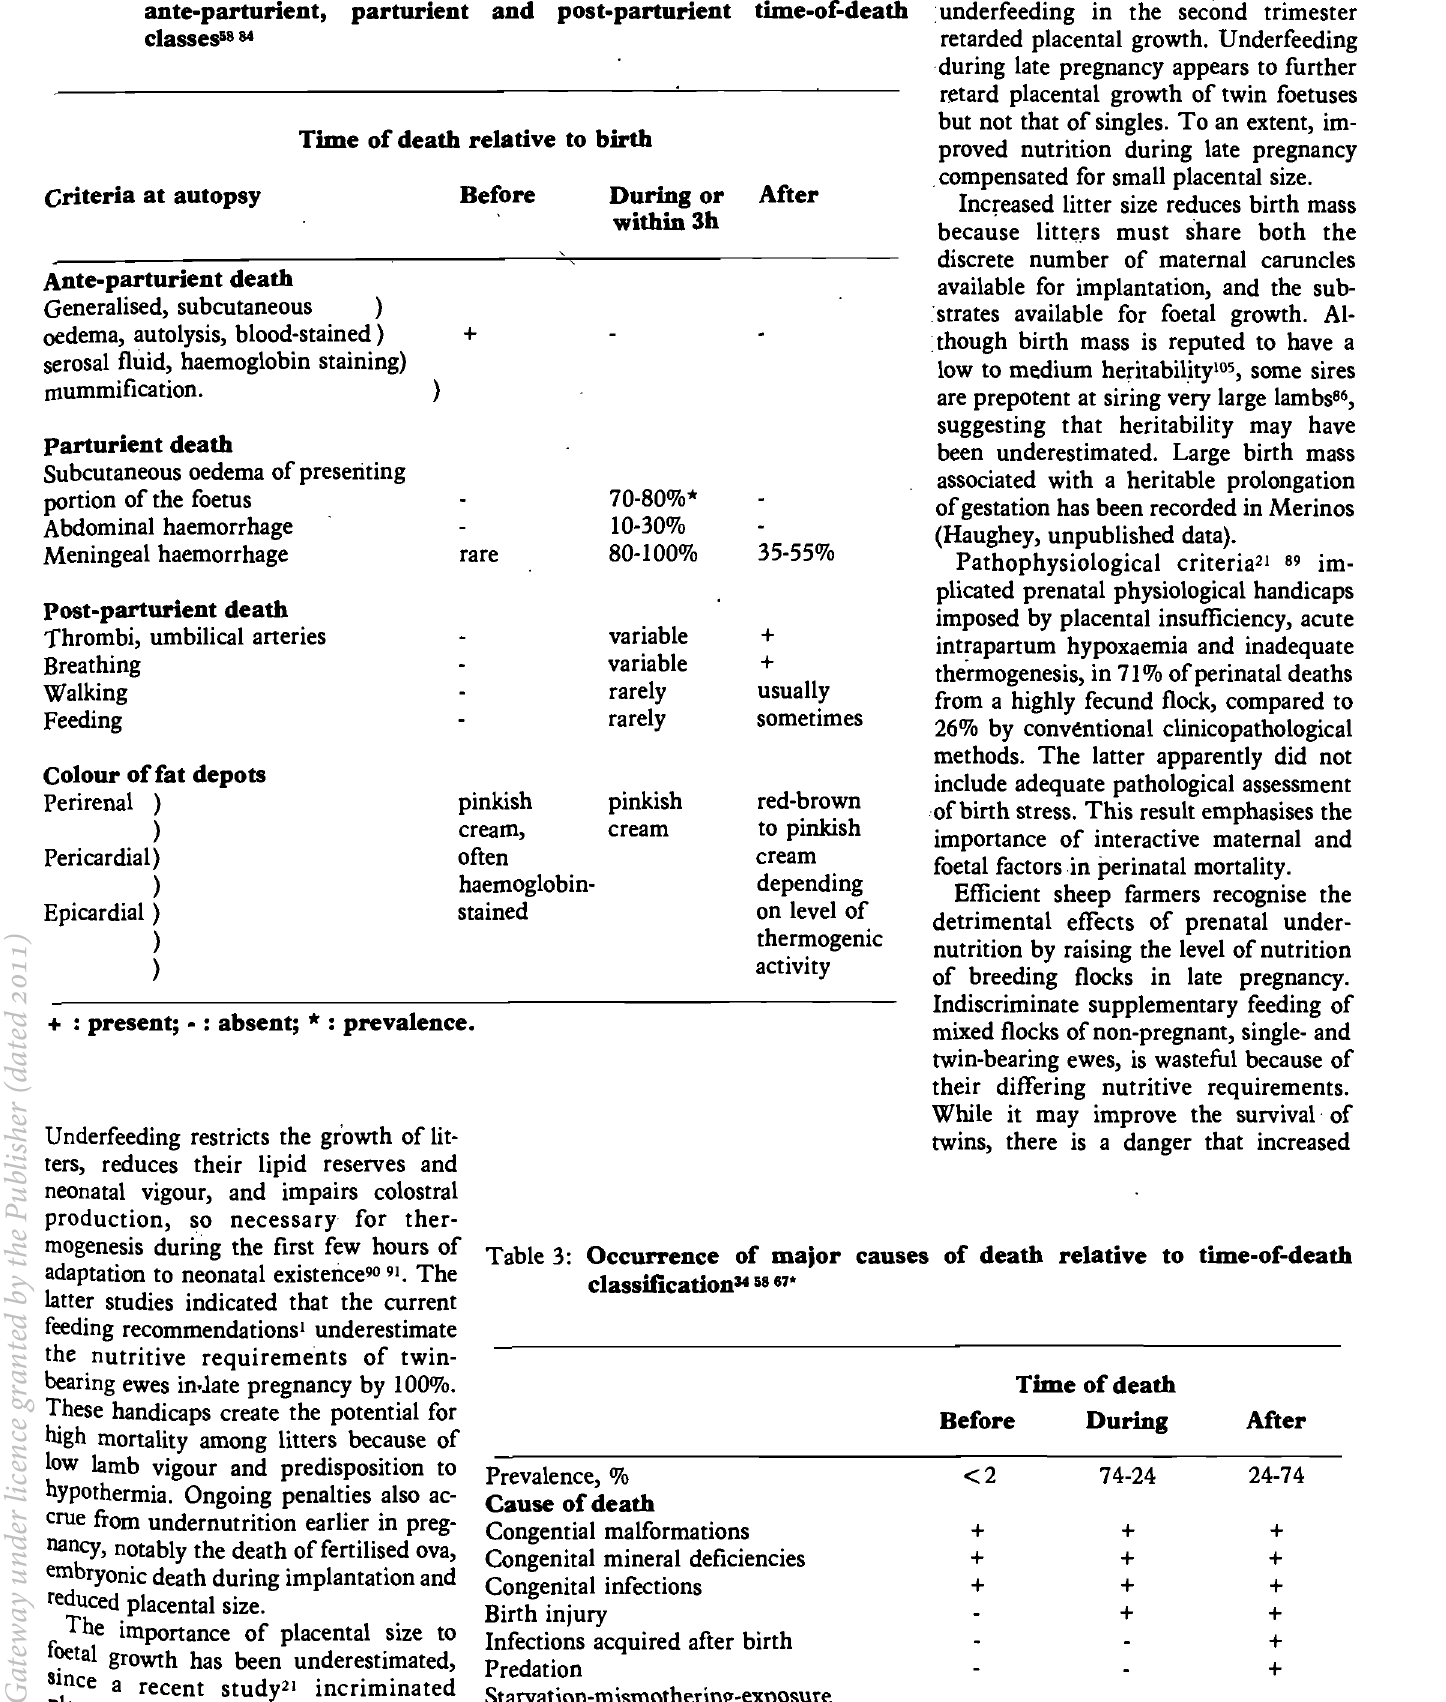
Table 2: Major pathological, and other relevant features characterising ante-parturient, parturient and post-parturient time-of-death